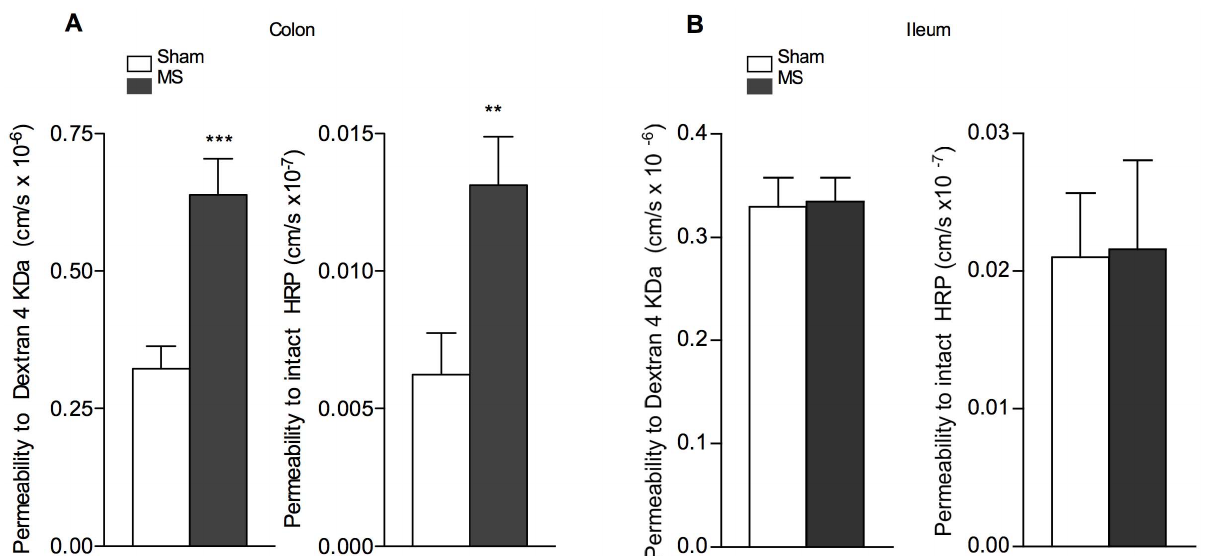
Figure 3. Effect of a single MS on colonic and ileal permeability to FD4 and intact HRP in PND10 rats. Ussing chambers measurements of mucosal-to-serosal permeability to Dextran 4 kDa and HRP 44 kDa in (A) colonic and (B) ileal segments of PND10 pups immediately after MS (T4 h). Note that MS increased FD4 and intact HRP permeability in the colon, but not in the ileum. Pooled data of both genders are shown and are expressed as the mean of permeability to FD4 (cm/s x10 2 6 ) 6 SEM in 9–16 animals per group, and HRP (cm/s 6 10 2 7 ) 6 SEM in 6–17 animals per group. *P , 0.05 **P , 0.01 compared to corresponding sham controls.